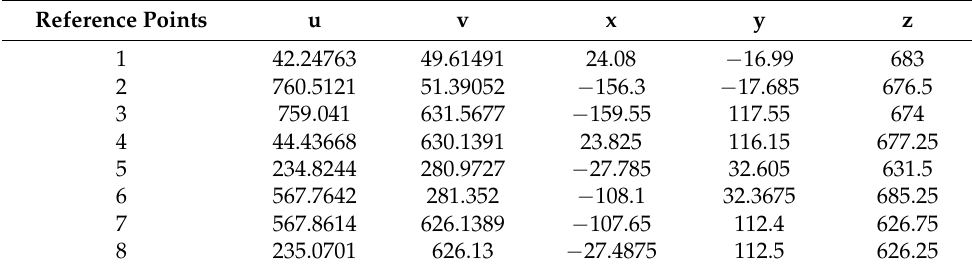
Table 3. The corresponding image coordinates and 3D coordinates of the selected reference points. Reference